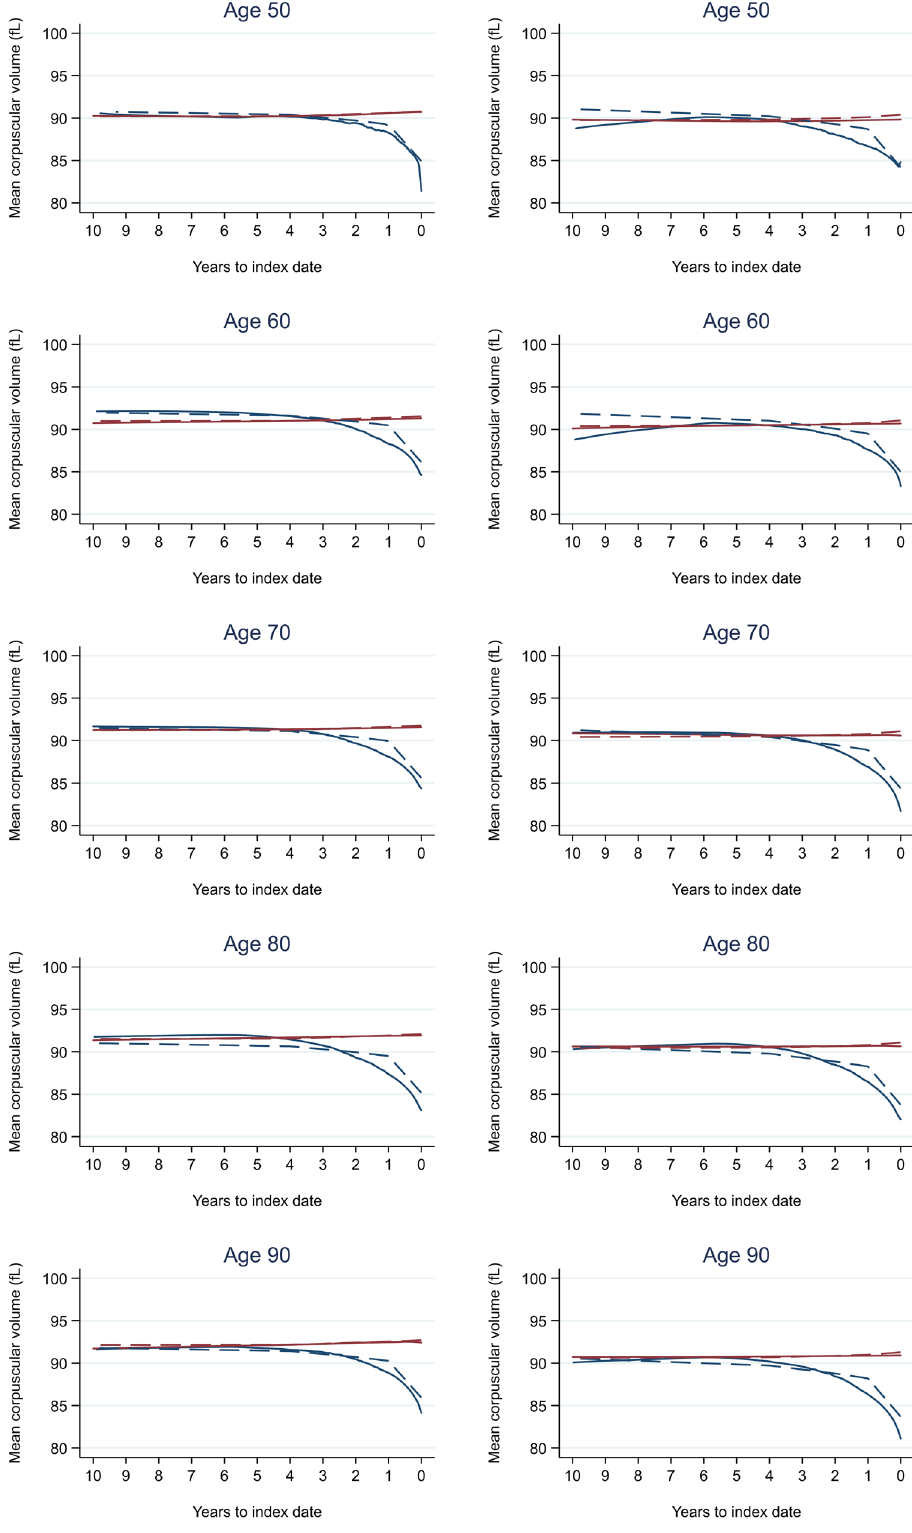
Figure 7. Mean corpuscular volume trends between cases and controls, by age at index date 1,2 . 1 Index date was the date of diagnosis for cases and a randomly selected date in the patient’s study period for controls. 2 LOWESS trends are age (+/- 3 years) and modelled (fixed effects) trends are taken at that specific age. Legend: males (left) and females (right). Colorectal cancer (blue line) and no cancer (red line). LOWESS trend (solid line) and modelled trend (dashed line).